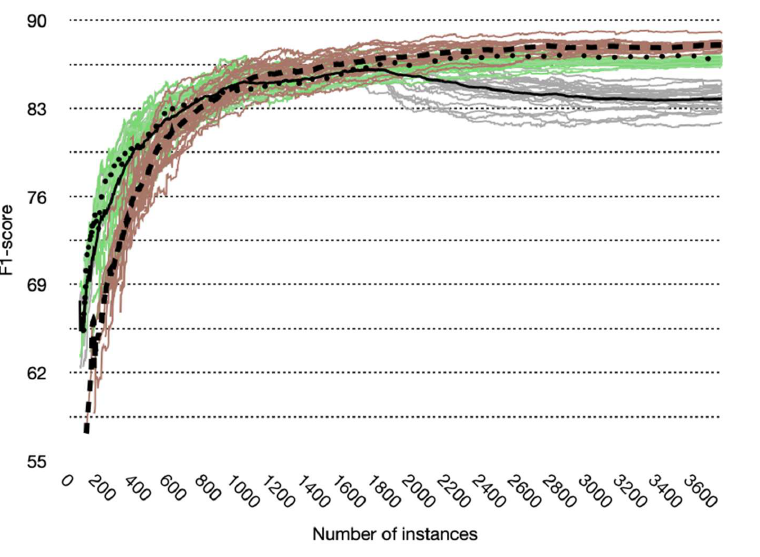
Table 5. Student’s t -test result. Comparison of F1 measure between older adults and control group.